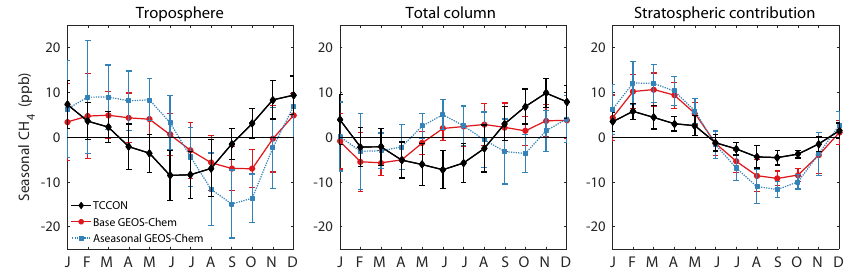
Figure 7. Detrended seasonality of TCCON (black diamonds), GEOS-Chem base (red circles), and GEOS-Chem aseasonal (blue squares) CH 4 column-averaged DMFs, averaged across Northern Hemisphere sites, excluding Saga, which has less than one year of measurements prior to 2012. Error bars denote the 1 σ standard deviation across sites.